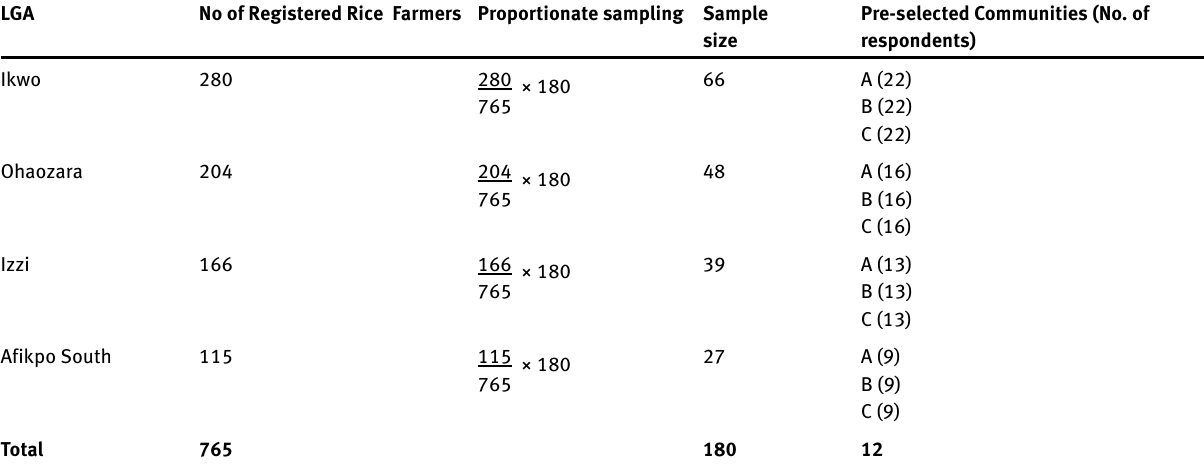
Table 1: Proportionate sampling of rice farmers in the study area